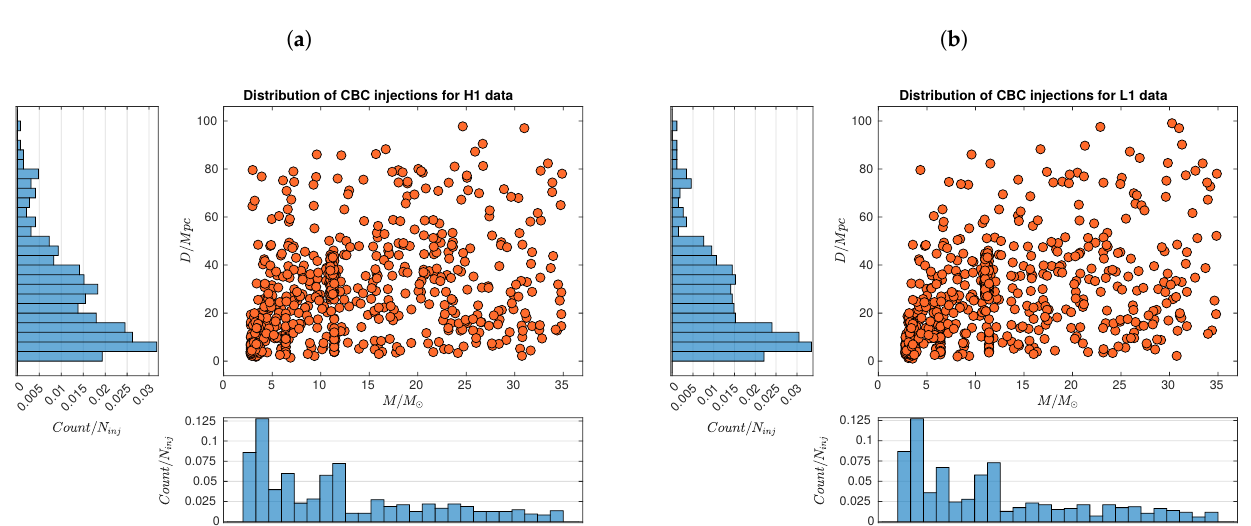
Figure 1. Distributions of hardware injections simulating GW emitted by CBCs that are present in S6 data from H1 ( a ) and L1 ( b ) LIGO detectors. The total masses M = m 1 + m 2 in solar mass units and distances D from the sources in megaparsecs are shown. Depending on M and D , we found are several regions in which GW events are more or less frequenct. In any case, the clearest trend in data is that, as distance D increase from 4 Mpc, GW events are less frequent. Data dowloaded from the LIGO-Virgo GWOSC: https://www.gw-openscience.org (accessed on 1 April